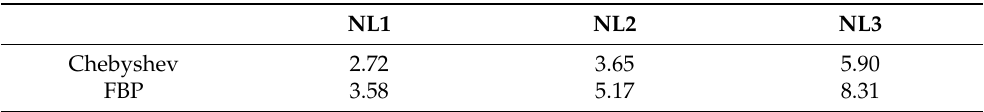
Table 1. Percentage standard deviation (% STD ) measurements for the uniform region of the simu- lated IQ phantom for Chebyshev and FBP reconstructions, for all noise